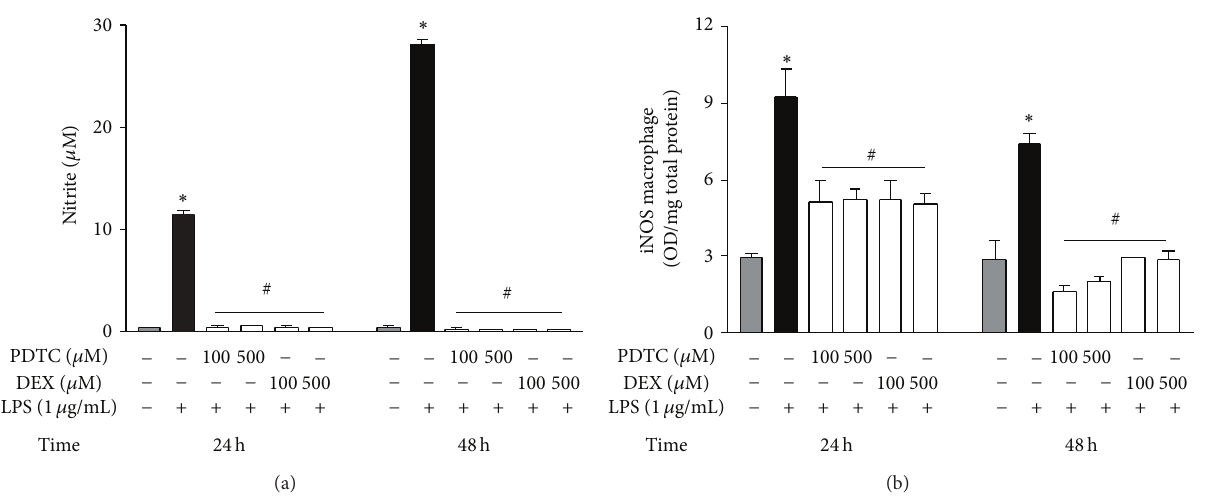
Figure 3: NF- 𝜅 B activation modulates LPS-induced iNOS expression by peritoneal macrophages. To demonstrate the importance of NF- 𝜅 B activation on LPS-induced iNOS expression, the macrophage culture was incubated with two different NF- 𝜅 B inhibitors [pyrrolidine dithiocarbamate (PDTC) and dexamethasone (DEX)] (100 and 500 𝜇 M) for 30 min before the addition of LPS (1 𝜇 g/mL) (time zero). The culture supernatant was collected for nitrite quantification by the Griess method (a), while the iNOS synthesis was determined in cell lysates by ELISA (b). Data is a representative of three independent experiments with similar results. Values are expressed as means ± S.E.M. 𝑛 = 4–10 samples per group. ∗ 𝑃 < 0.05 versus saline and # 𝑃 < 0.05 versus LPS group.